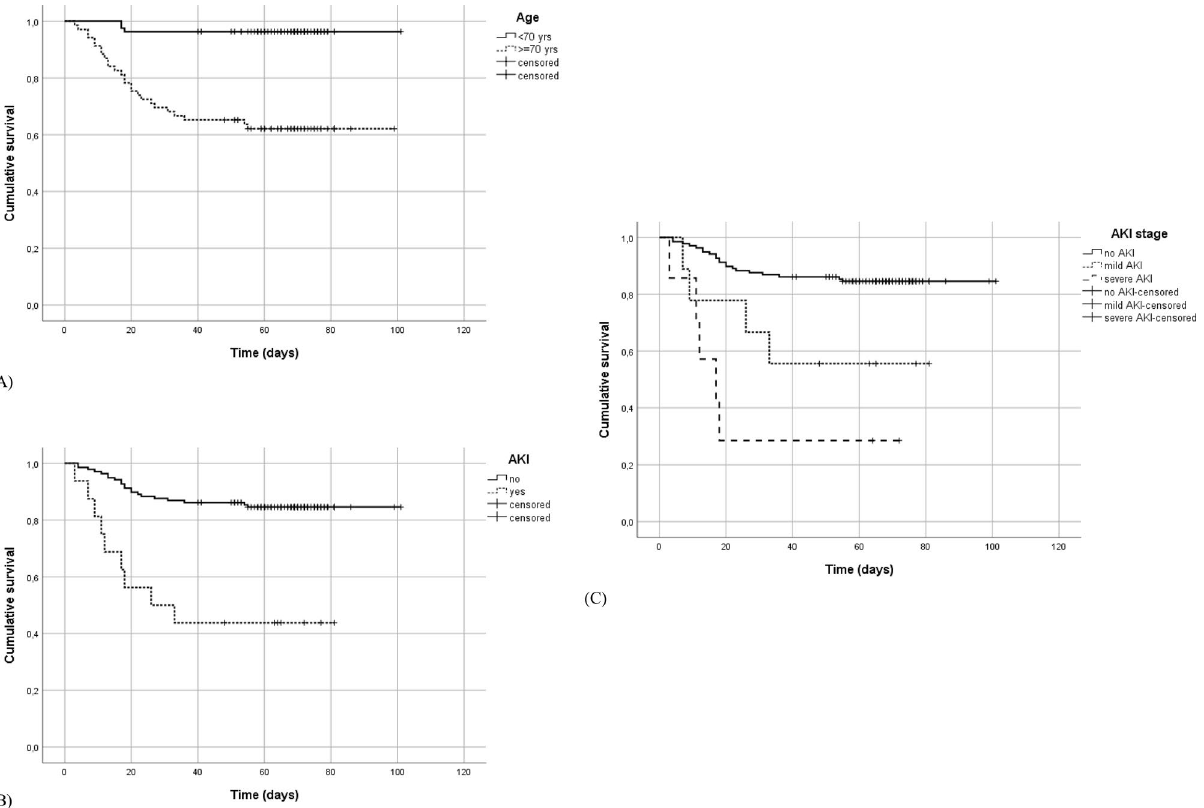
Figure 1. Kaplan–Meier plots of mortality. Curves represent mortality in ( A ) = patients over and under 70 years old—Logrank test: p < 0.001. ( B ) = patients with and without occurrence of Acute Kidney Injury (AKI)— Logrank test: p < 0.001. ( C ) = patients without and with mild (stage 1) and severe (stage 2–3) Acute Kidney Injury (AKI)—Logrank test: p < 0.001, pairwise comparisons: no AKI vs. mild AKI: p = 0.014; no AKI vs. severe